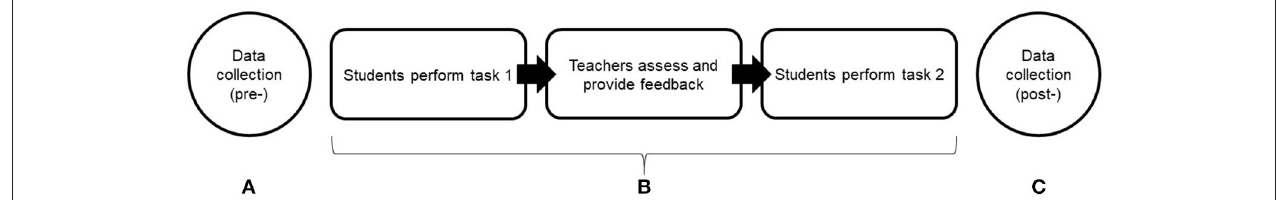
FIGURE 3 | Procedure for the teaching sequences and data collection: (A) Preceding each teaching sequence was a data collection (knowledge test and motivation questionnaire); (B) During the teaching sequence, the students performed an open-ended task, which was assessed by the teacher, who also provided feedback, and the students performed another (similar) task where they could use their feedback; (C) Each teaching sequence concluded with another data collection (knowledge test and motivation questionnaire). Questionnaires for perceived clarity of goals and assessment criteria were distributed during the teaching sequences (B)